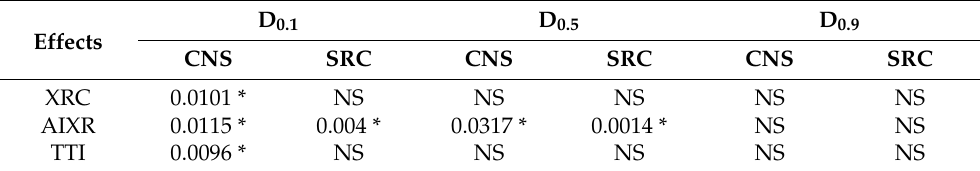
Table 6. ANOVA results ( p -values) for D 0.1 , D 0.5 , and D 0.9 by nozzle type for CNS and SRC. D 0.1 , D 0.5 , and D 0.9 are the droplet diameters ( µ m) where 10%, 50%, and 90%, respectively, of the spray volume is contained in the spray droplets smaller than this value. CNS represents the sprayer without a rate controller and SRC represents the sprayer equipped with a rate controller. Effects